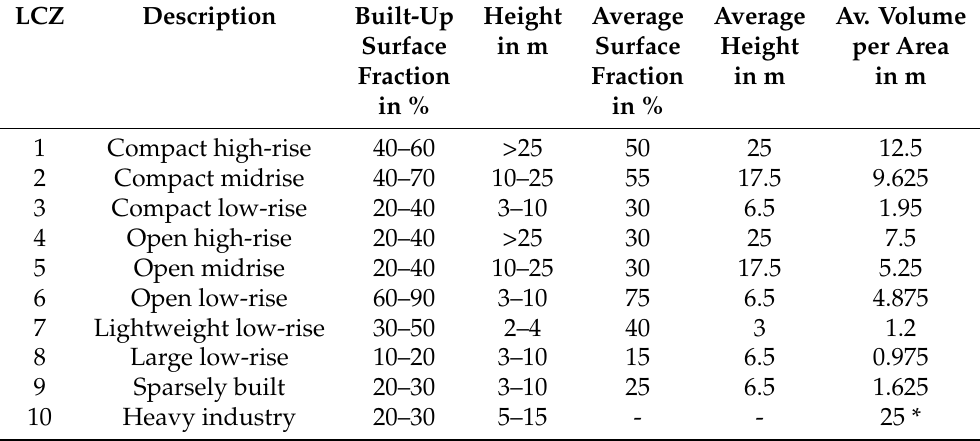
Table 1. Local climate zones adapted from [13]. * The value for the local climate zone class 10 (heavy industry) is calculated by doubling the highest value occurring in the other classes (i.e., 12.5 m/A for class